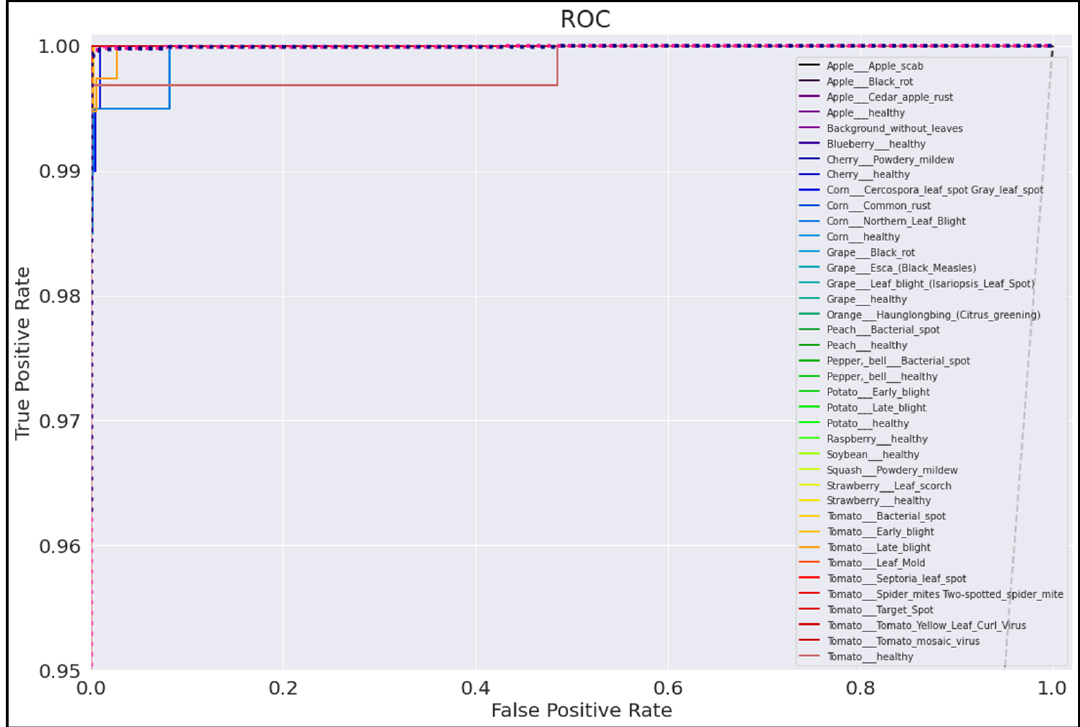
Figure 23. ROC Curve for EfficientNetB0 model with transfer learning Scenario 4 and Proposed hy- perparameters.